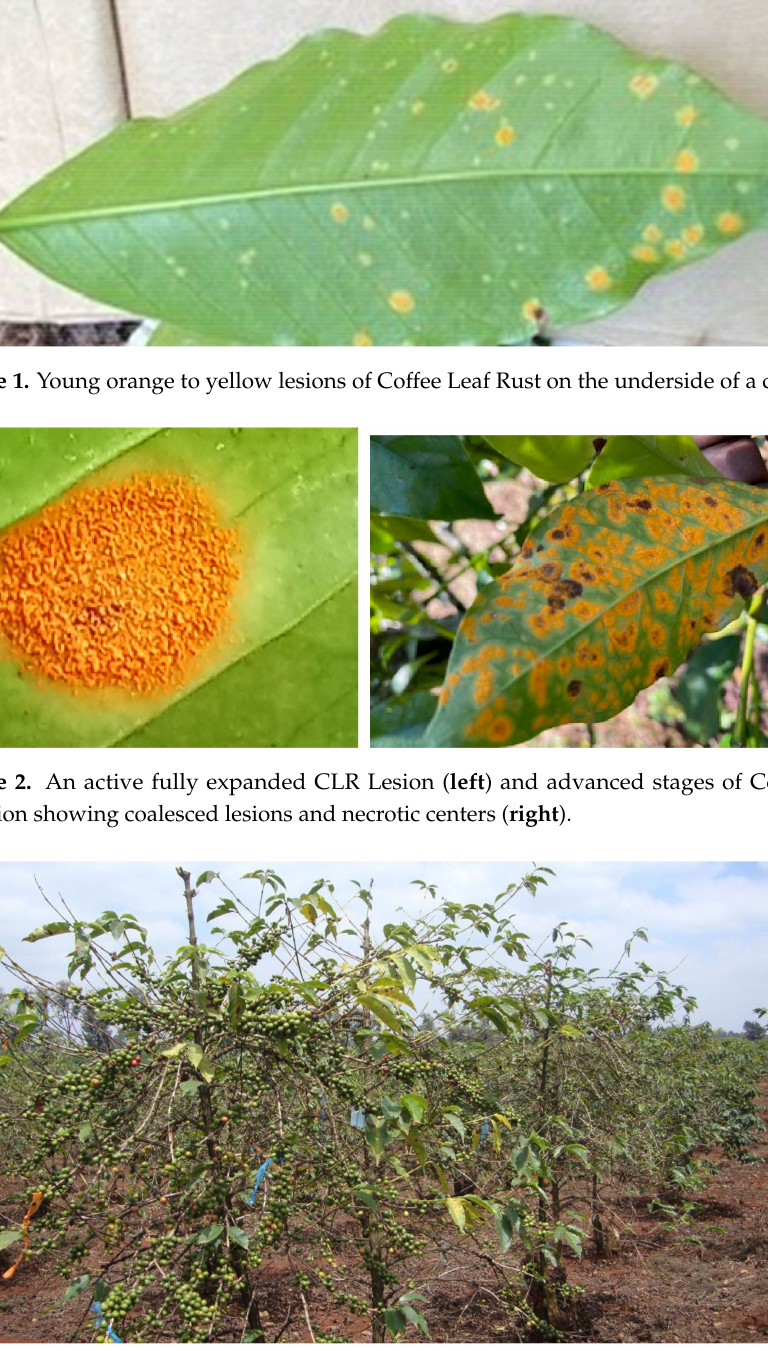
Figure 3. Coffee trees defoliated due to Coffee Leaf Rust